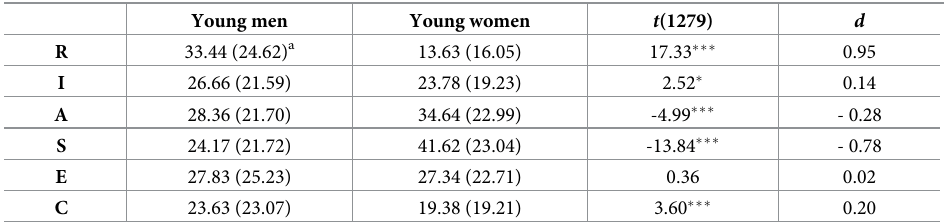
Table 5. Gender differences in interests: Mean, standard deviation, t -test and Cohen’s d .